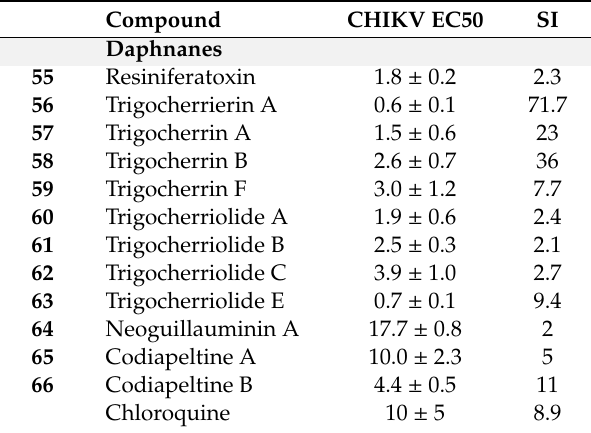
Table 2. Anti-CHIKV activities of daphnanes 55 – 66 .